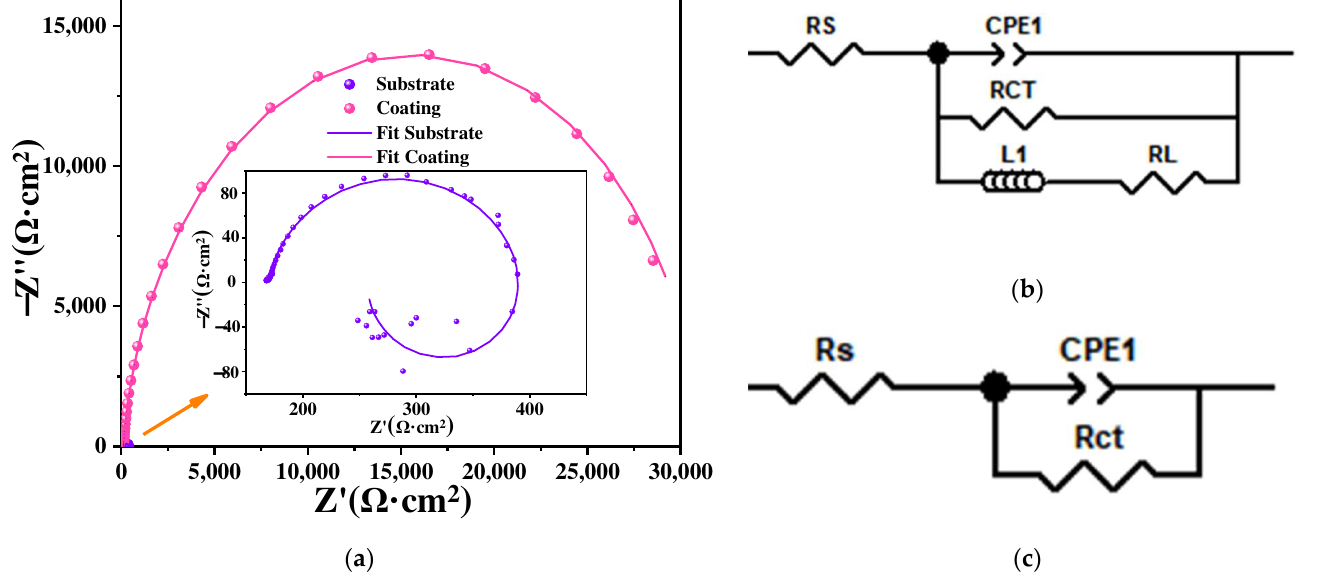
Figure 8. EIS diagrams of LZ91 Mg–Li alloy substrate and optimized upper surface Ni–P coating in 3.5 wt% NaCl solution: ( a ) Nyquist plot; ( b ) equivalent circuit diagram of the substrate; ( c ) equivalent circuit diagram of optimized upper surface Ni–P coating.